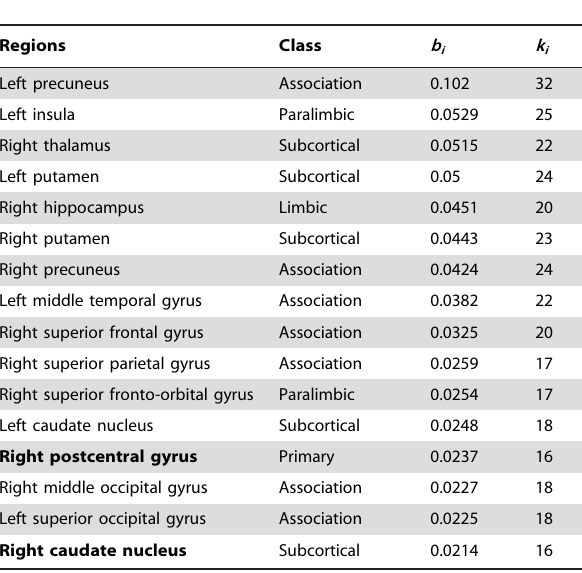
Table 5. Hub regions of the EB group.